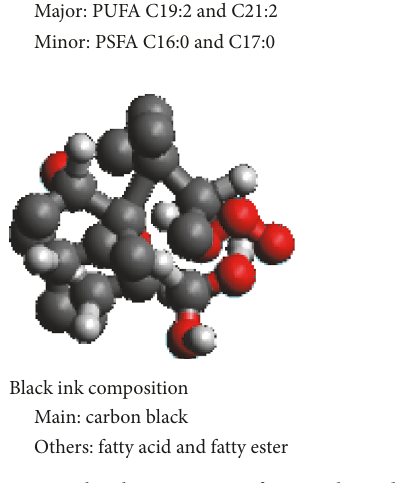
Figure 4: Molecular structures of materials used in this